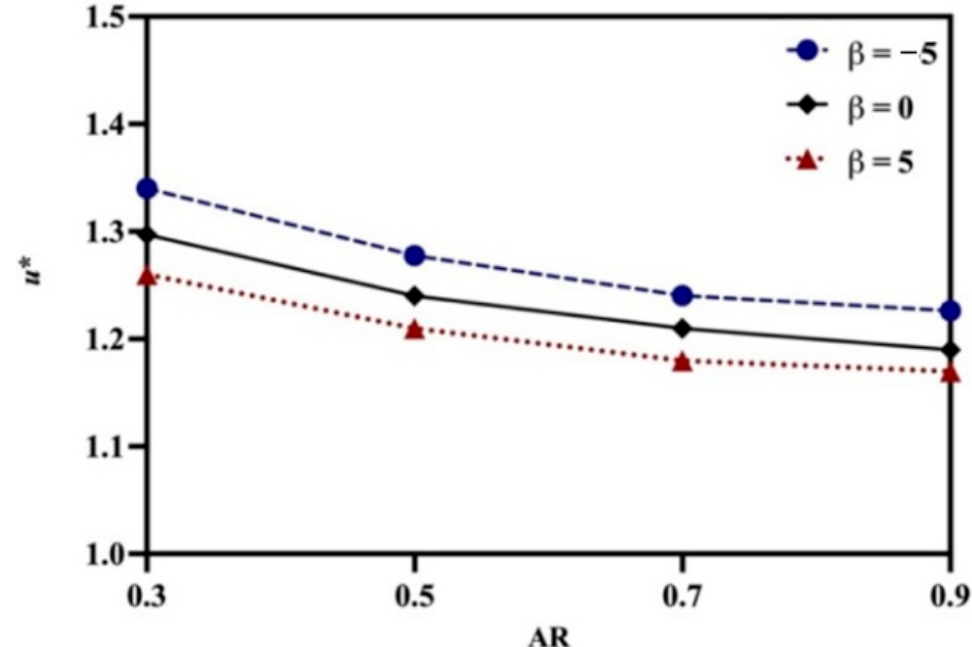
Figure 13. Relationship between u * and AR.